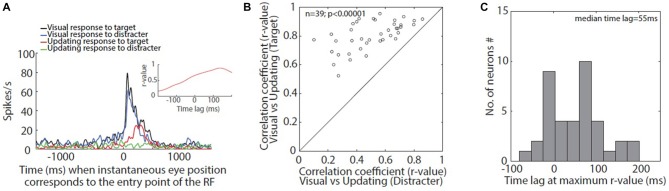
(A) Time aligned spike density function (SDF) of visual and updating responses: black and blue SDF corresponds to visual responses when target or distracter corresponded with entry point of the example neuron’s RF, respectively. Red and green SDF corresponds to updating responses for target and distracter, respectively. The inset shows the correlation between visual and updating response towards the target at different time lags. This neuron shows maximum correlation (r-value) when updating response lags behind the visual response by 137 ms. (B) Correlation between visual and updating responses: correlation between visual and updating response for target is plotted as a function of correlation for the distracter. All the neurons show a higher correlation between visual and updating response for target when compared with that for distracter. (C) Time lag for best correlation: shows the histogram representation of the time lag or lead when visual and updating responses showed maximum correlation across the sample of neurons. The median lag for the population was 55 ms, i.e., updating response lagged behind visual response by 55 ms.